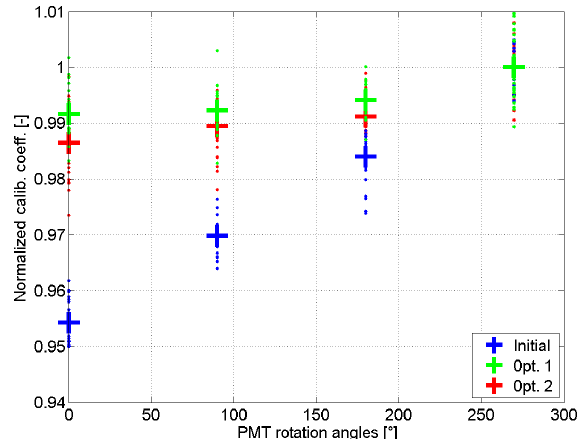
Figure 5. Normalized calibration coefficient as a function of PMT rotation angle (test no. 1 in Fig. 4) for three optical configura- tions of the detection subsystem: (blue) initial configuration (sim- ilar to the DEMEVAP campaign), (green) optimized configuration no. 1 (0.4mm fiber), and (red) optimized configuration no. 2 (1mm